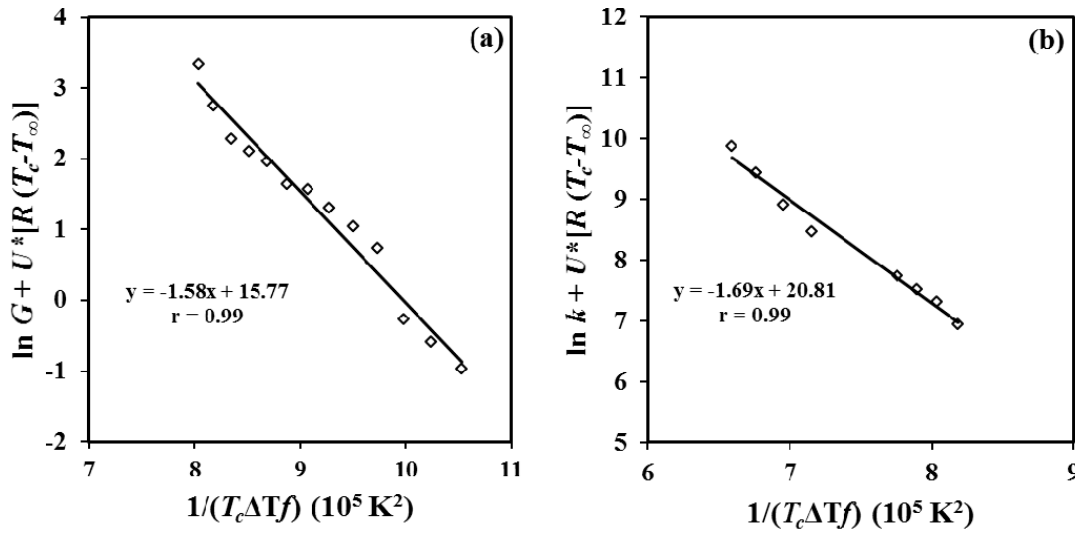
Figure 15. Lauritzen-Hoffman plots for the crystal growth rate ( a ) and the overall crystallization rate ( b ) for the isothermal crystallization of P4HB.